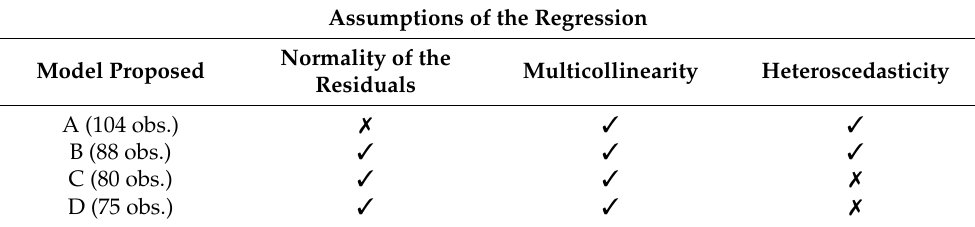
Table 4. Summary of the validated assumptions for models A, B, C, and D. Assumptions of the Regression Normality of the Model Proposed